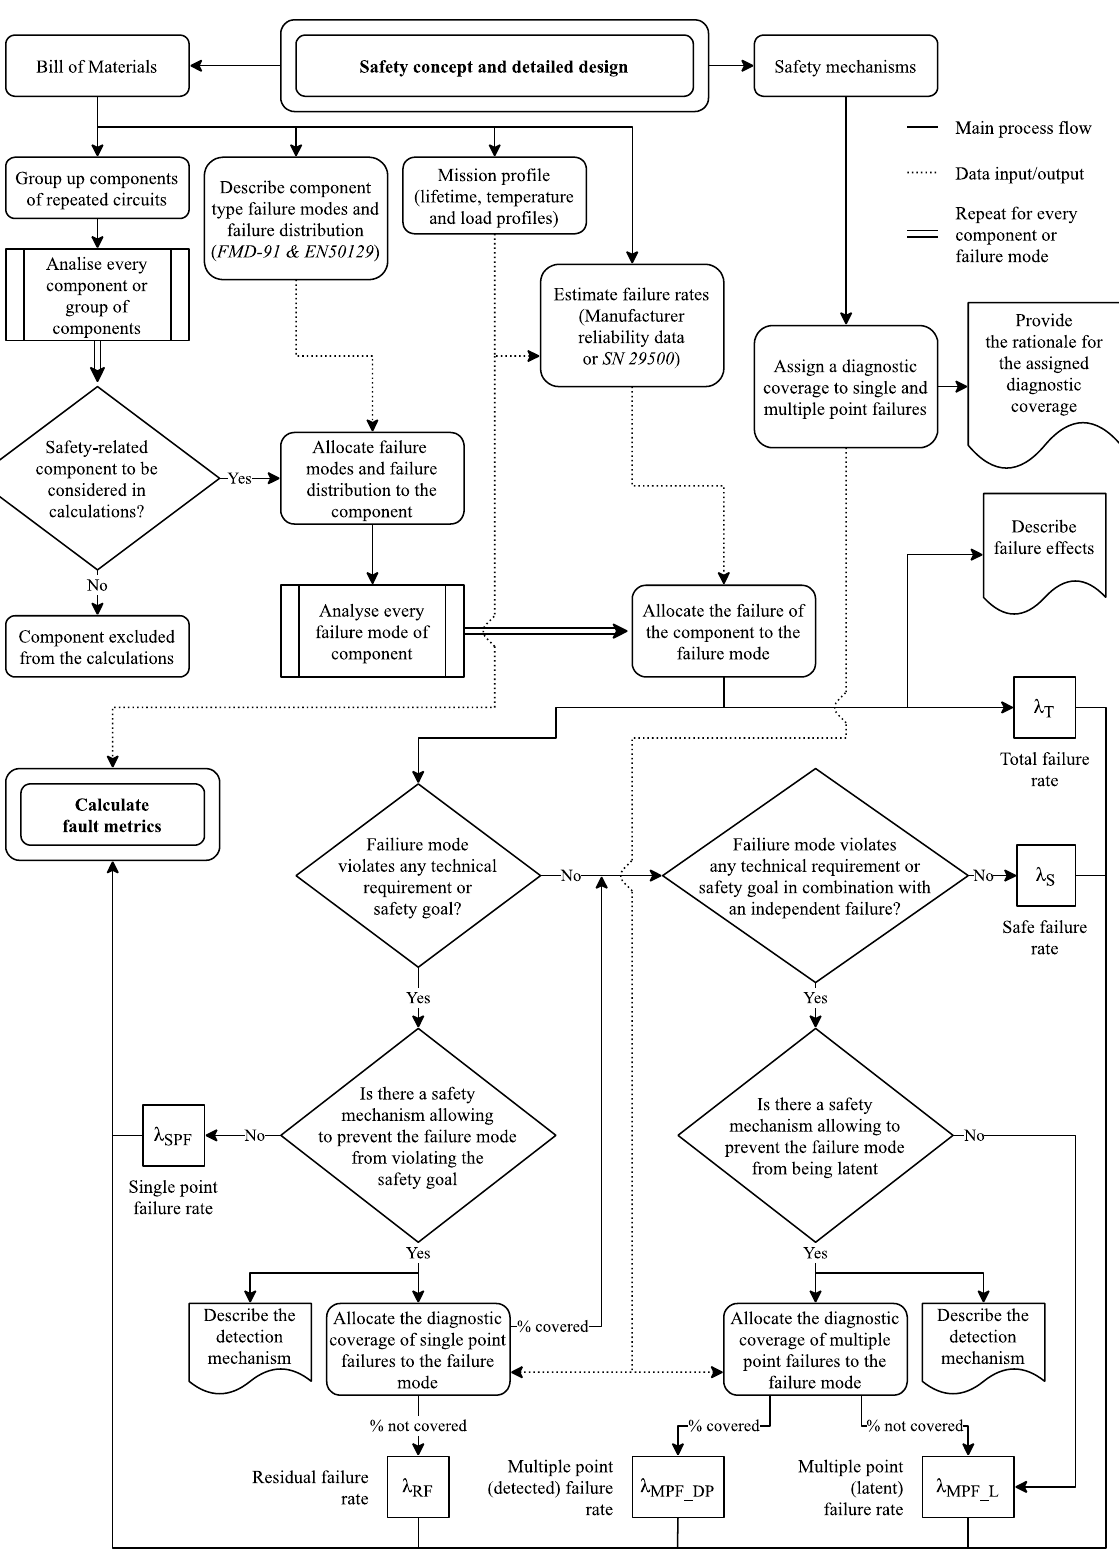
Figure 6. Procedure followed for the realization of the FMEDA.